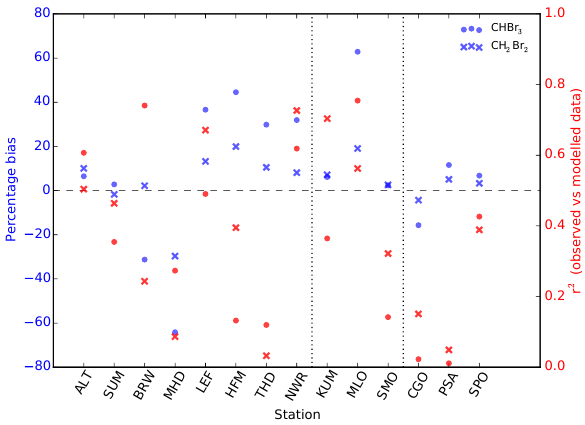
Figure A1. Mean annual percentage model bias (blue) calculated at NOAA ground station sites (Table 2) for CHBr 3 (dots) and CH 2 Br 2 (crosses). The horizontal dashed line denotes zero bias. The right- hand-side y axis describes the ability of the model to reproduce observed variations ( r 2 ) (red). The vertical dotted lines define the tropical